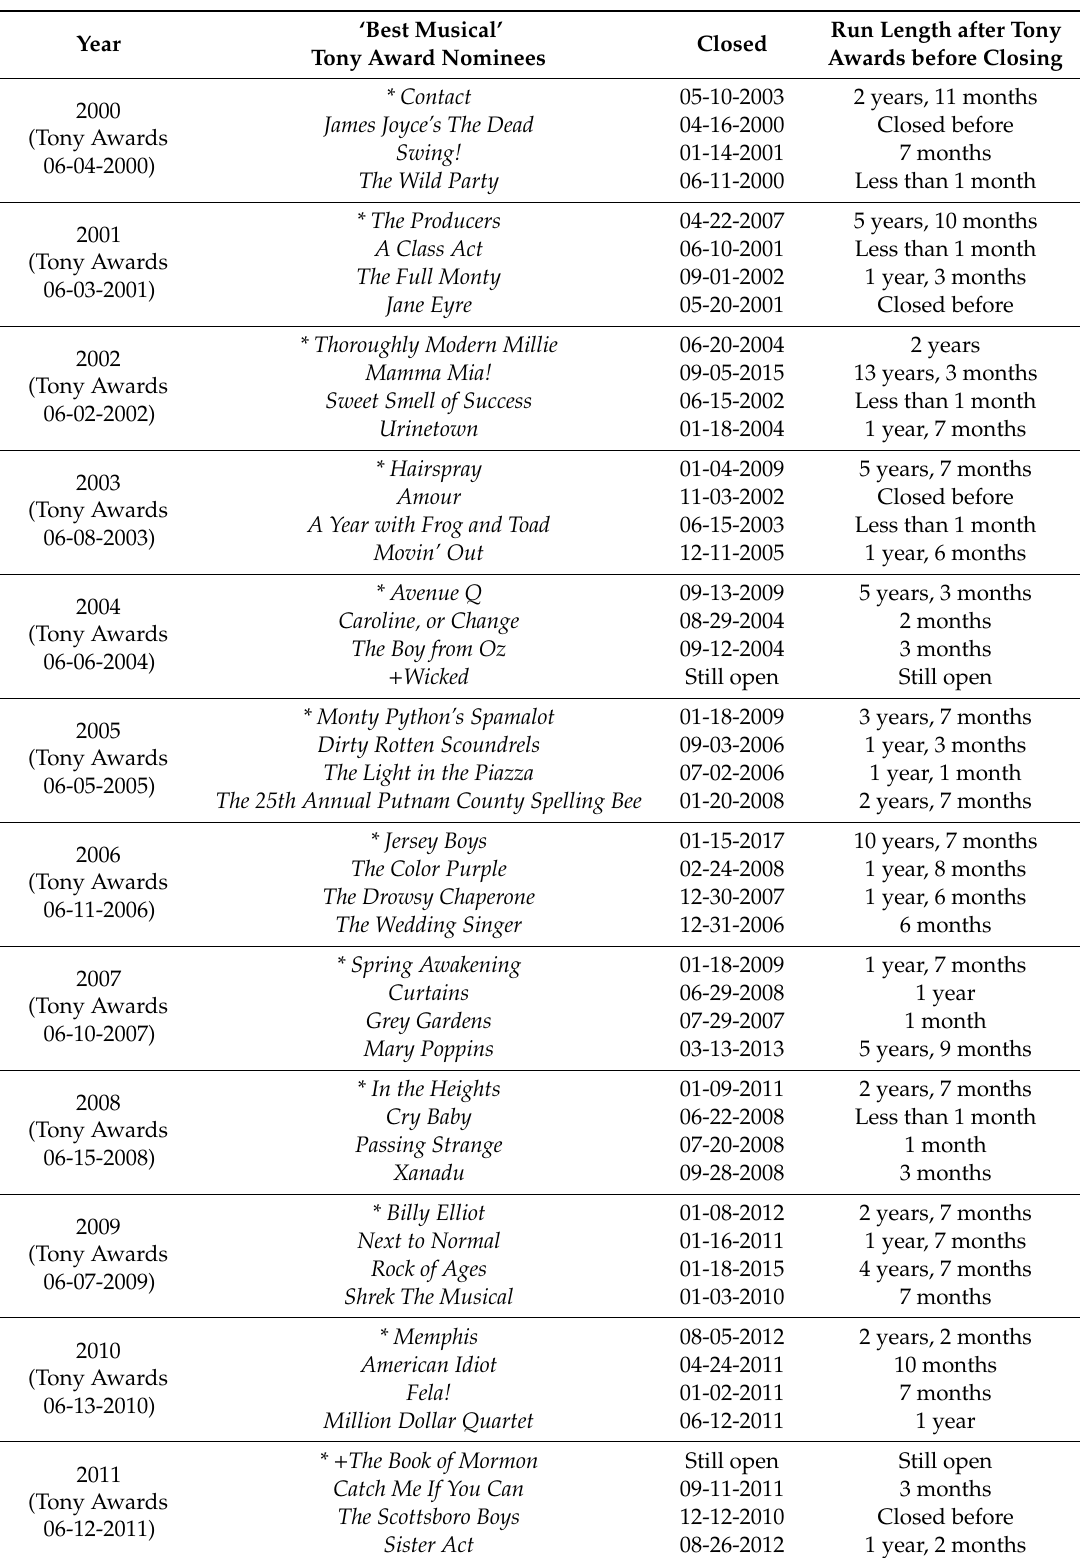
Table 3. ‘Best Musical’ Tony Award winners and nominees by year